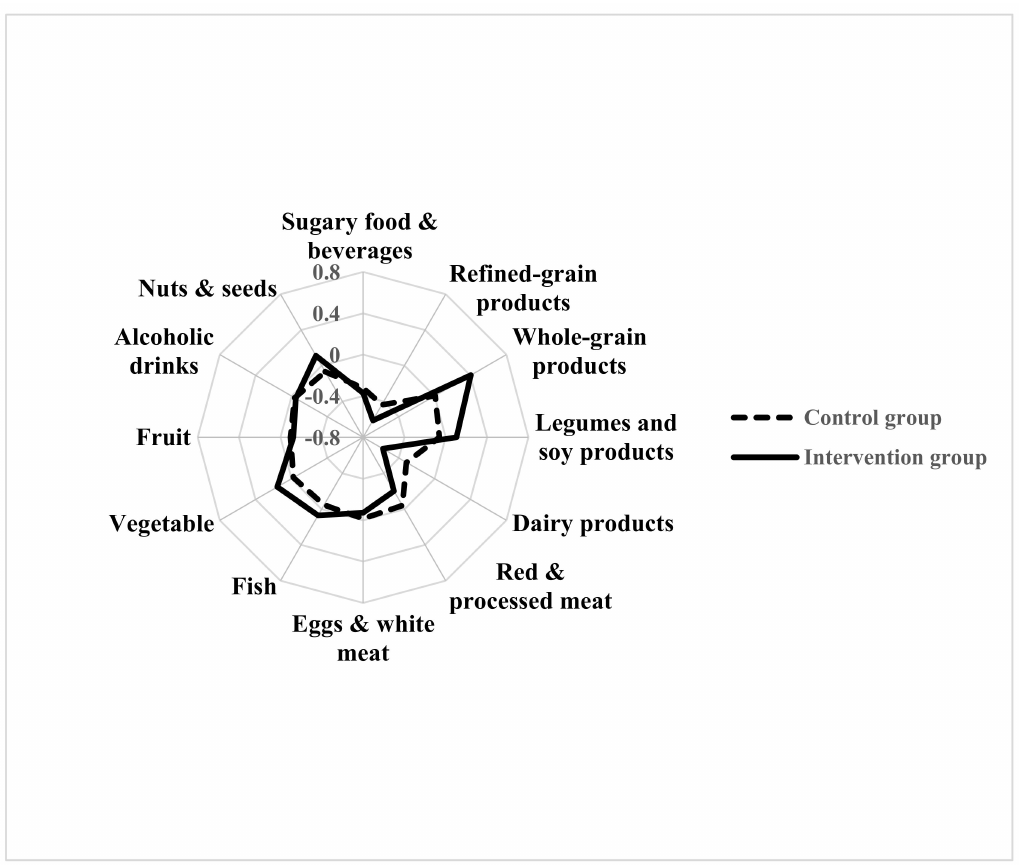
Figure 2. Changes in frequencies of food consumption by randomization group (intention-to-treat analysis, 416 women). Table 3. Adjusted ORs (95% CIs) of reduction of IGF-I ( ∆ IGF-I, tertiles) according to the reduction of body weight ( ∆ Weight), animal products, legumes and refined products consumption. ∆